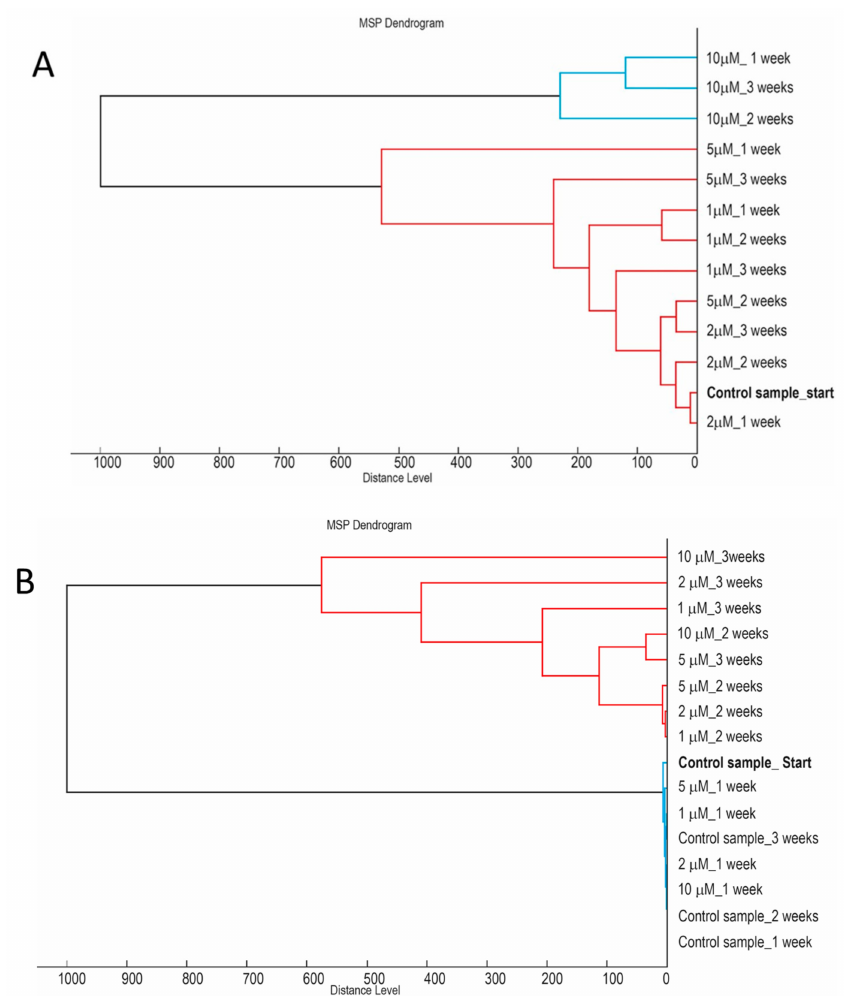
Figure 7. Hierarchical trees of Synechococcus sp. UPOC S4 cells based on IC MALDI-TOF mass spectra. Multiple spectra were processed for samples cultivated in the presence of sodium azide ( A ) and streptomycin ( B ) in MALDI Biotyper Compass Explorer 4.1 (Bruker Daltonik) to generate main spectral projections (MSPs). A library of the MSPs was then used for tree